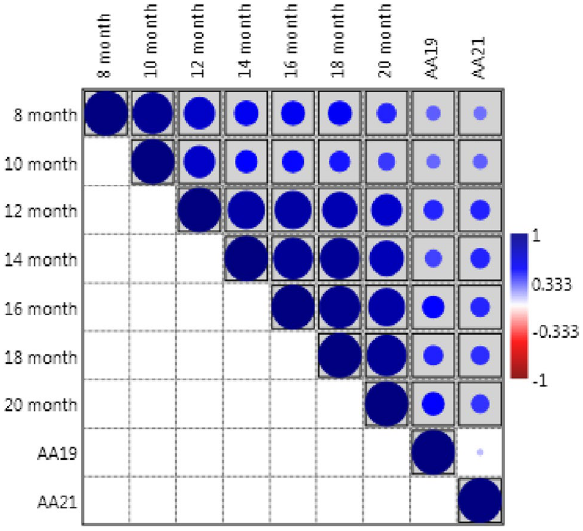
Figure 4. Correlation matrix of natural ageing (8–20 months) and accelerated ageing ( AA accelerated